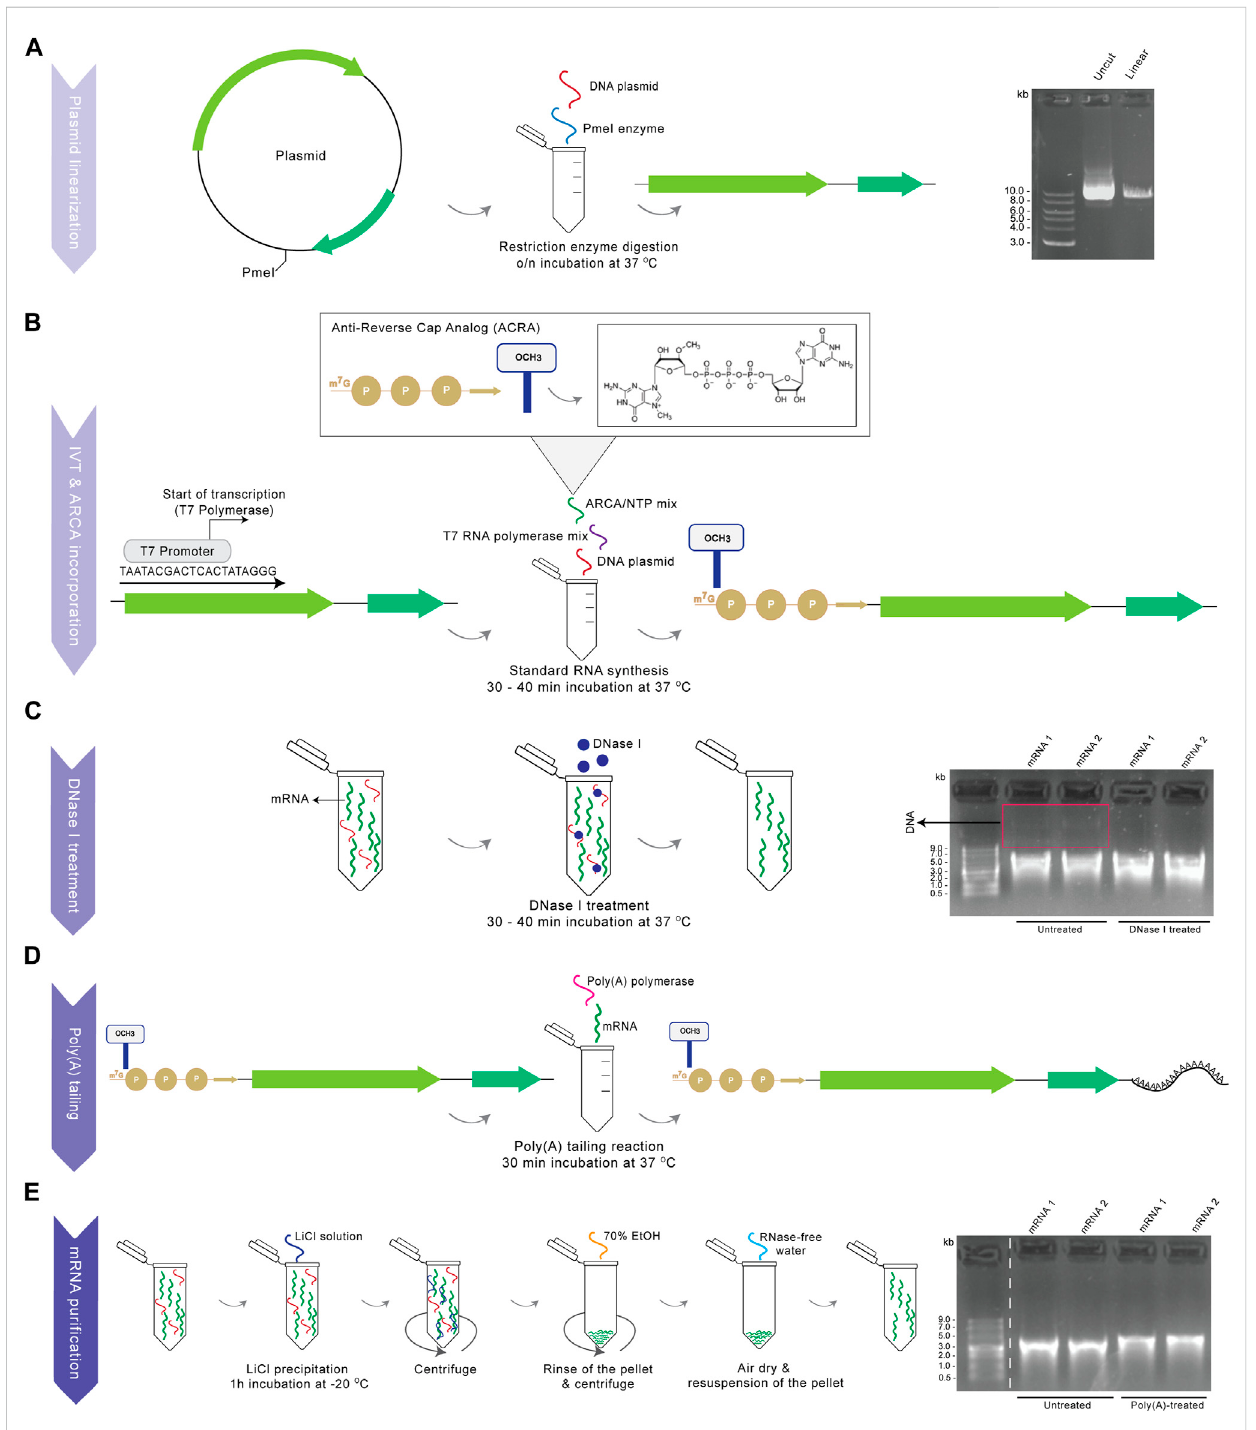
FIGURE 1 Production of functional mRNA. Schematic diagram showing all the steps for the current in vitro transcription protocol, with corresponding gel images for theexampleoftworepresentative BEmRNA synthesis procedures (1,2)from thesameplasmid. (A) Linearization ofplasmidDNAbyrestriction enzyme digestion downstream of the ORF to create a template for mRNA synthesis. After step A, uncut and linearized plasmid was loaded on a 0.8% agarose gel, along with a 1 kb DNA ladder (gel image) (B) Synthesis of a capped mRNA by co-transcriptional incorporation of ARCA using T7 RNA polymerase. (C) DNase I treatment of the capped mRNA for the removal of DNA residuals. The mRNA product was loaded on a 1% agarose gel untreated (from step B) and DNase I treated (from step C) (gel image) (D) Tailing reaction using poly(A) polymerase for the addition of a poly(A) tail to the capped mRNA. (E) Puri fi cationofthe fi nalmodi fi edmRNAfollowingLiClprecipitation.Finally,thecappedRNAproductwasloadedona1%agarosegeluntreated (from step D) and puri fi ed and poly(A)-treated (from step E), along with a ssRNA ladder (gel image). Dashed white lines indicate where images were simpli fi ed by removal of surplus